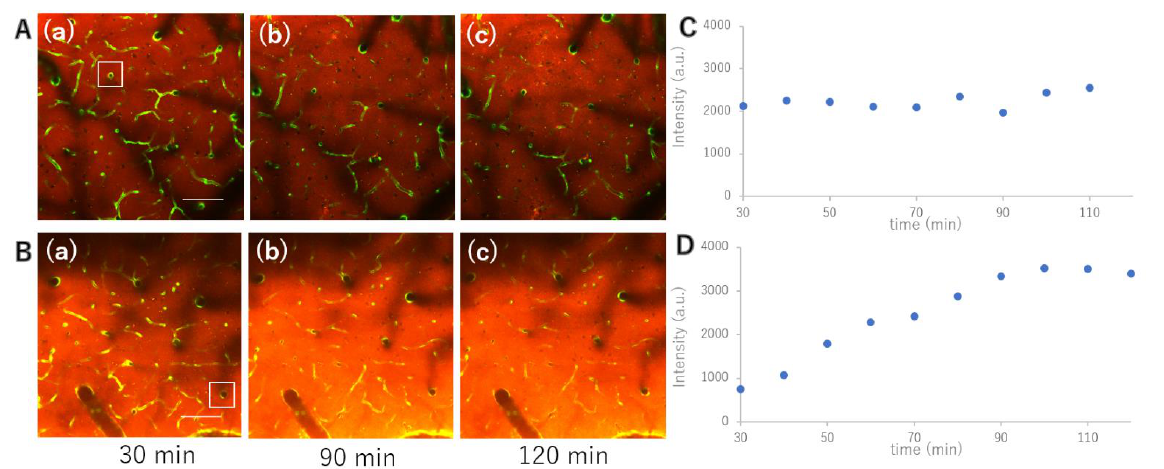
Figure 5. Dynamic transportation of TRITC-dextran at 4.4 kD ( A ) and 40 kD ( B ) was measured in a Tie2-GFP mouse. Progressive accumulation of 40 kD dextran in the perivascular space was observed ( B ), whereas 4.4 kD dextran reached a plateau within 30 min after topical application ( A ) ( (a ) 30 min, ( b ) 90 min, ( c ) 120 min after the dextran administration). Fluorescent intensity of squares in ( A (a)) and ( B ( a )) was periodically measured (( C ) and ( D ), respectively). Scale bar: ( A ( a ) and B ( a )) 100 μm .